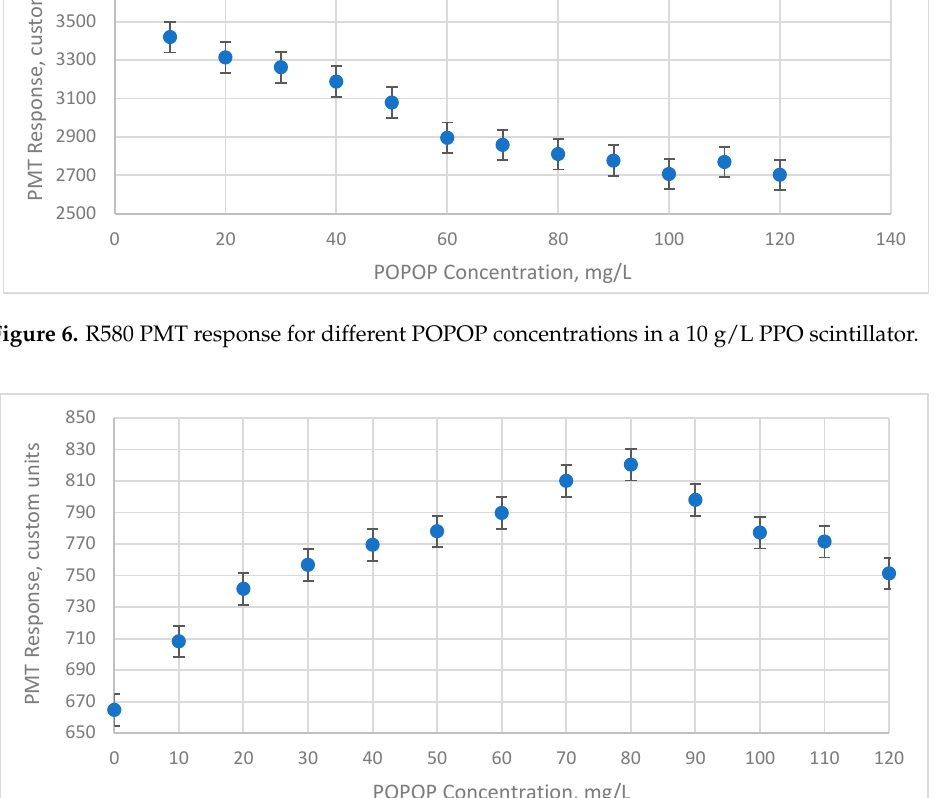
Figure 6. R580 PMT response for different POPOP concentrations in a 10 g/L PPO scintillator.